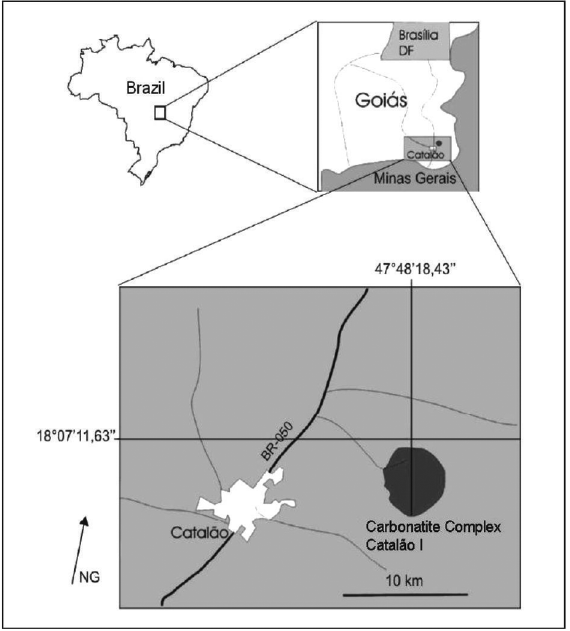
Fig. 1. Location map of the Carbonatitic Complex of Catalão I, which is the depositional site of the Cemitério Paleolake. Modified from Cardoso and Iannuzzi (2006).